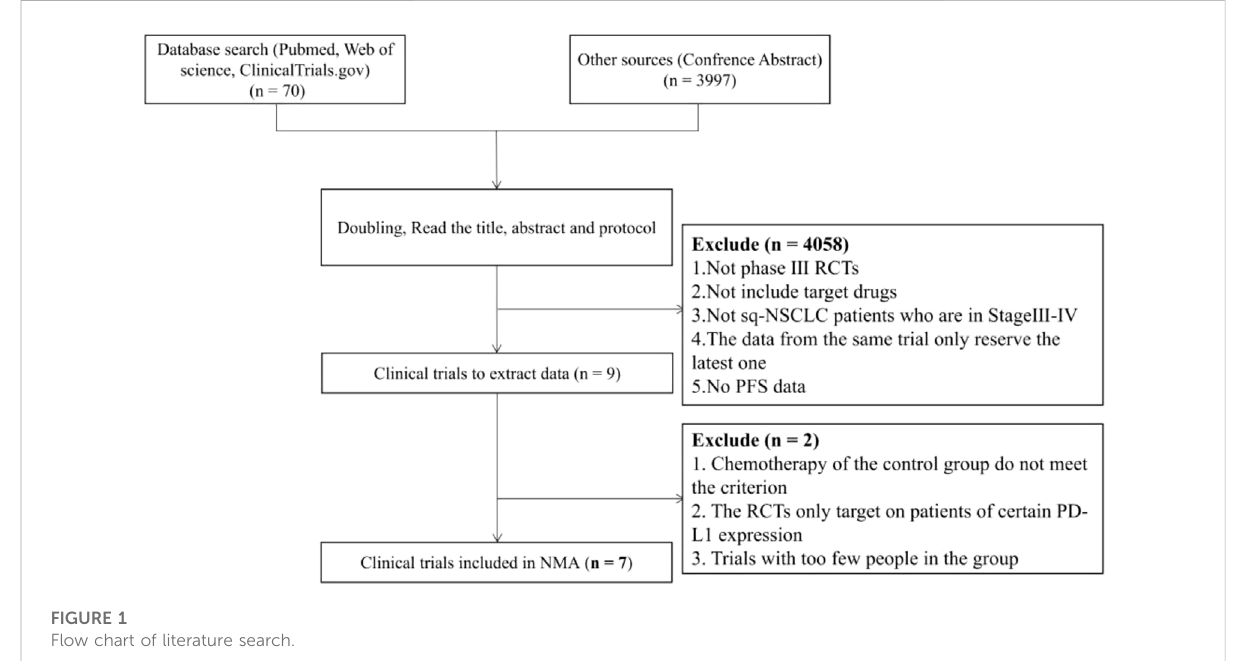
FIGURE 1 Flow chart of literature search.